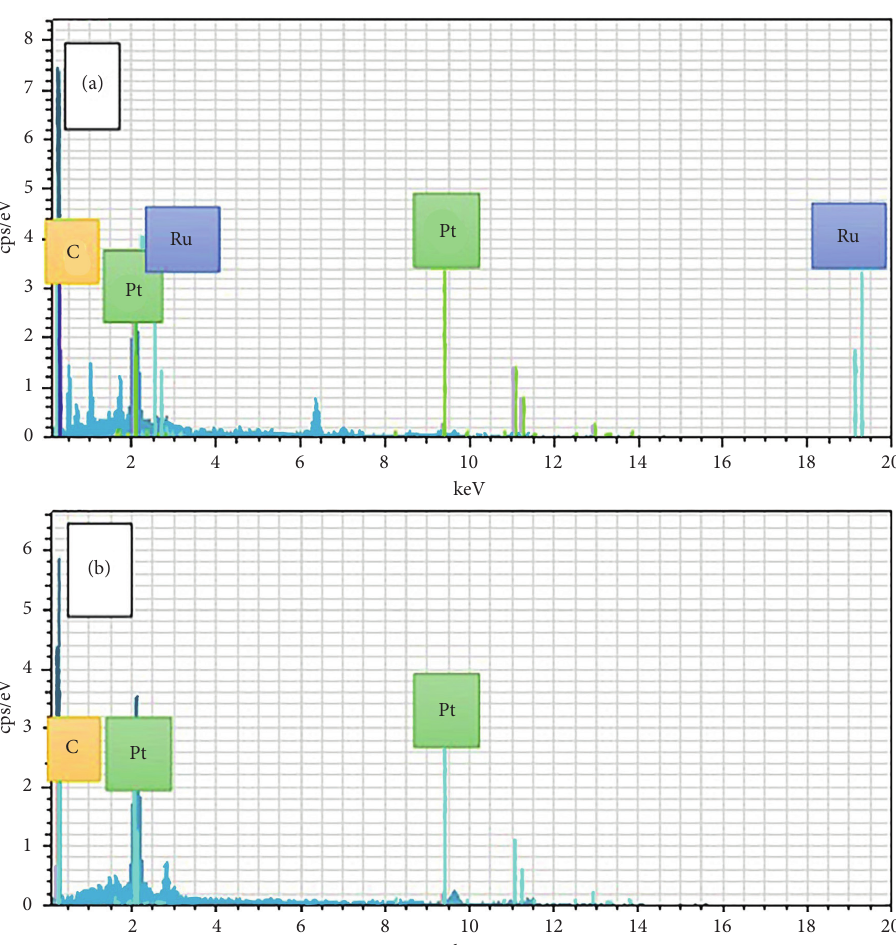
Figure 3: EDX image of (a) PtRu loaded on the anode and (b) Pt loaded on the cathode.